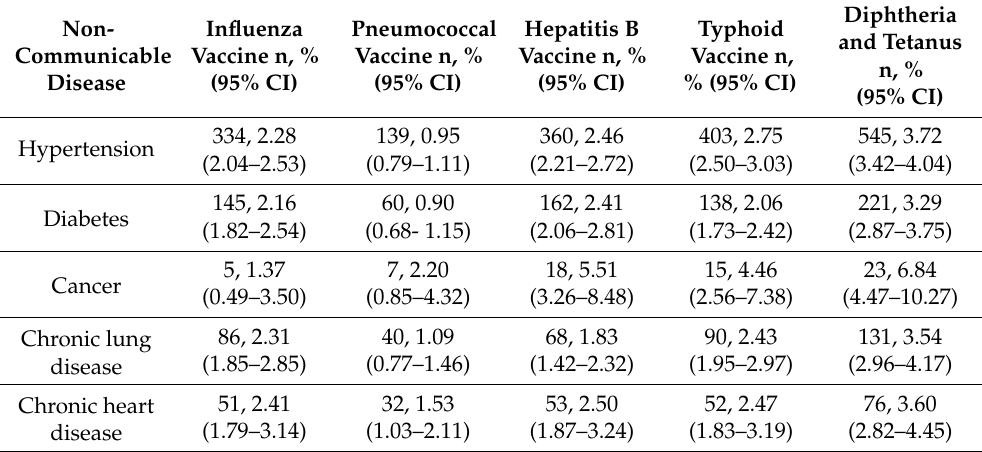
Table 4. Coverage of adult vaccines across selected non-communicable diseases among adults in